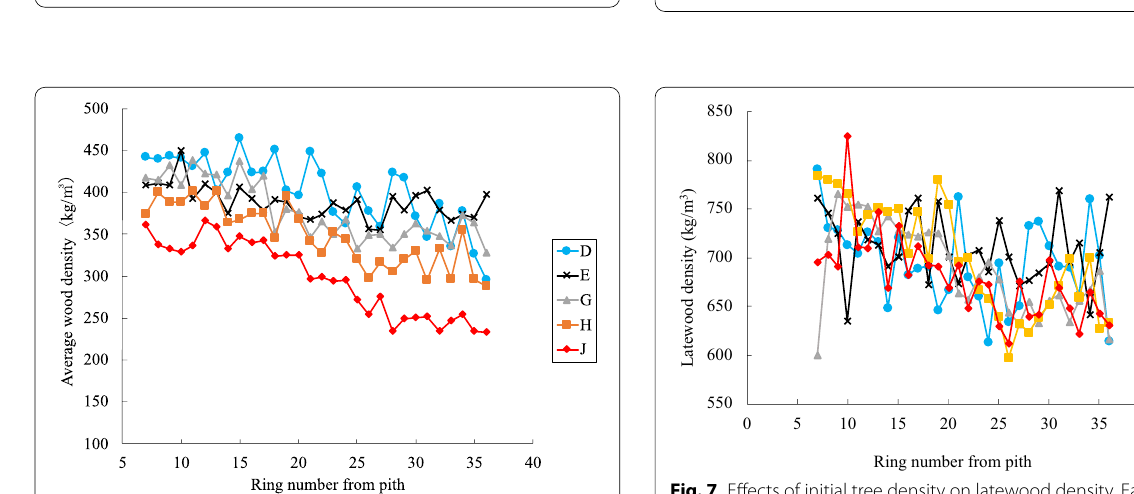
Fig. 6 Effects of initial tree density on earlywood density. Each plot shows an average value in a ring number among sample trees of each tree density zoning symbol. Number of sample trees of each initial tree density zoning symbol range from five to nine. Initial tree density zoning symbols were the same, as shown in Table 1